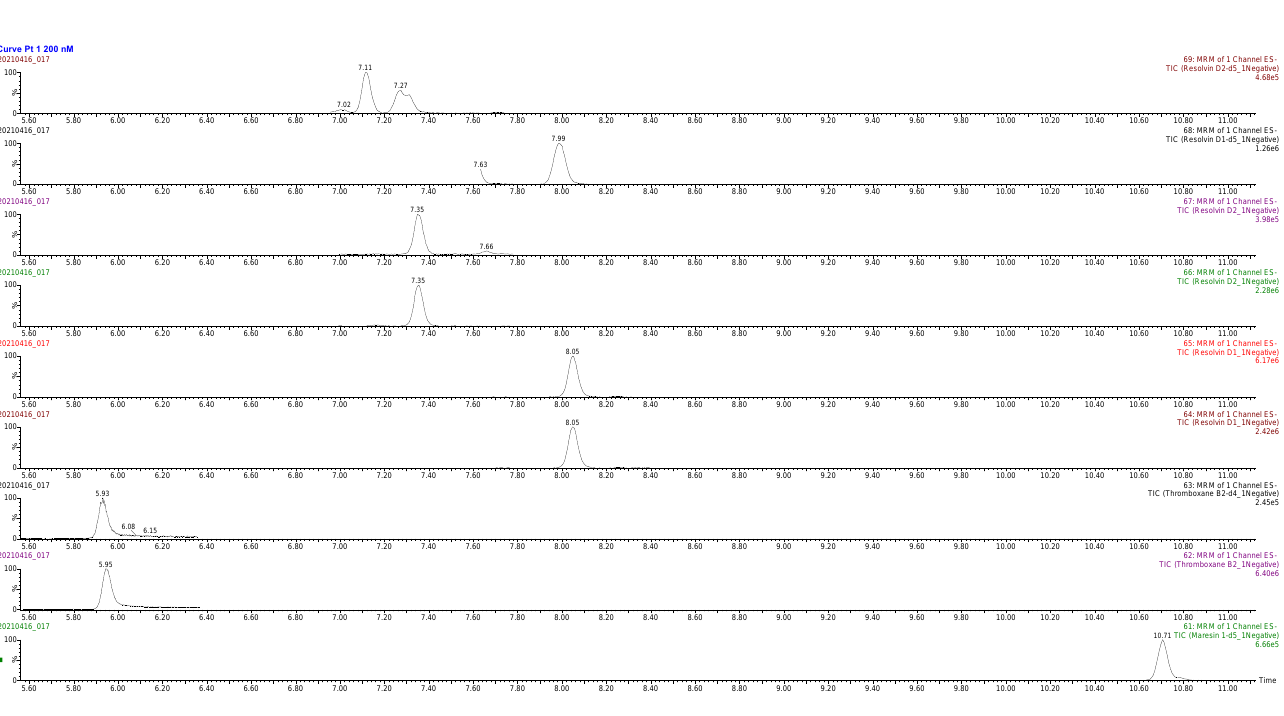
60: MRM of 1 Channel ES- TIC (_ ± _19(20)-DiHDPA_1Negative) 2.97e6 20210416_017 59: MRM of 1 Channel ES- TIC (Maresin 1_1Negative) 1.02e6 10.76 20210416_017 58: MRM of 1 Channel ES- TIC (Maresin 1_1Negative) 5.27e5 10.76 20210416_017 57: MRM of 1 Channel ES- TIC (Lipoxin A4-d5_1Negative) 1.03e6 7.97 7.62 20210416_017 56: MRM of 1 Channel ES- TIC (PGF1a_1Negative) 5.48e6 6.65 20210416_017 55: MRM of 1 Channel ES- TIC (13,14-dihydro-PGF2a_1Negative) 1.37e6 7.47 7.22 7.61 20210416_017 54: MRM of 1 Channel ES- TIC (Prostaglandin E2-d4_1Negative) 1.95e7 6.85 20210416_017 53: MRM of 1 Channel ES- TIC (Resolvin E1-d4_1Negative) 5.06e5 4.82